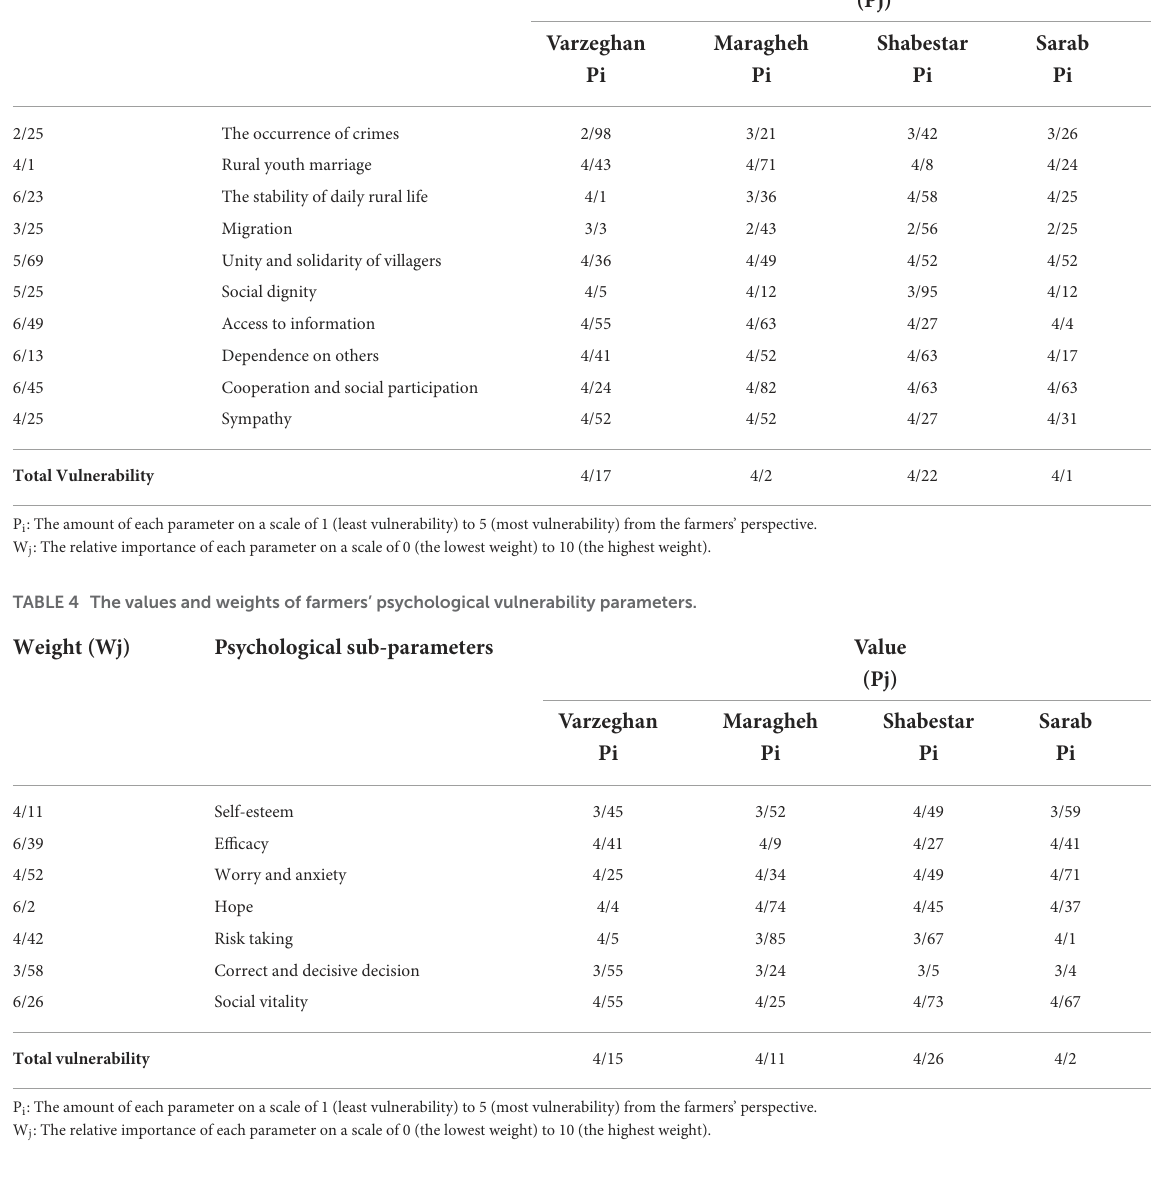
TABLE 3 The values and weights of farmers’ social vulnerability parameters. Weight (Wj)